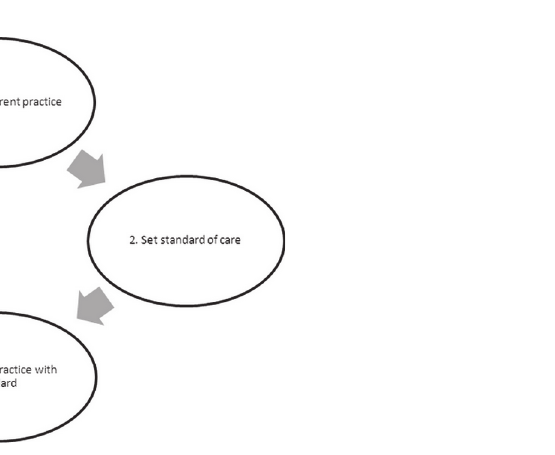
Fig 1. The audit cycle (adapted from Crombie et al 1993)